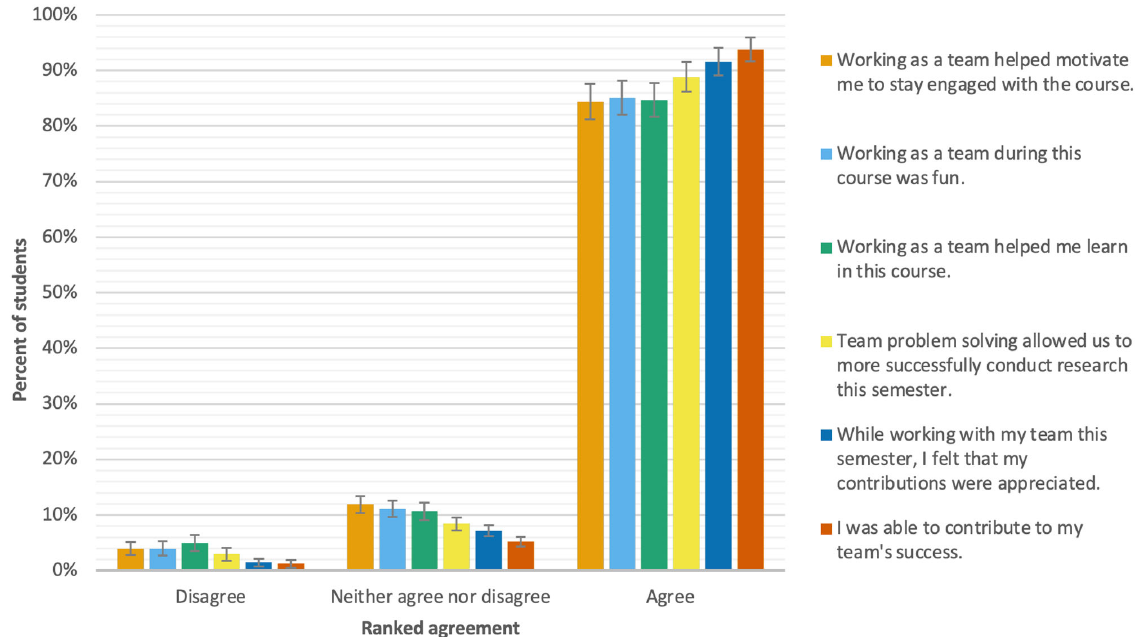
FIG. 7. Students ranked agreement with statements on teamwork at the end of the course. Students responded to a 5-point Likert scale from strongly disagree to strongly agree. The responses presented in the graph have been collapsed to a 3-point scale. The uncertainty was calculated using the 95% binomial confidence interval with n ¼ 404